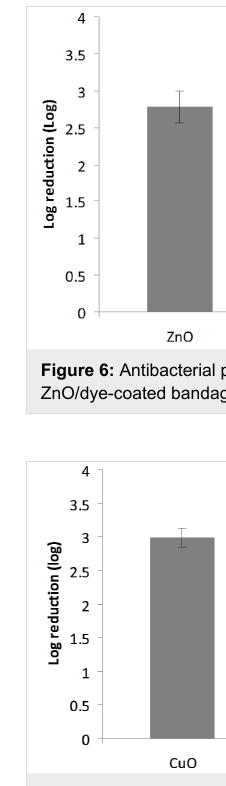
Figure 7: Antibacterial properties of CuO-coated bandages and CuO/dye-coated bandages.